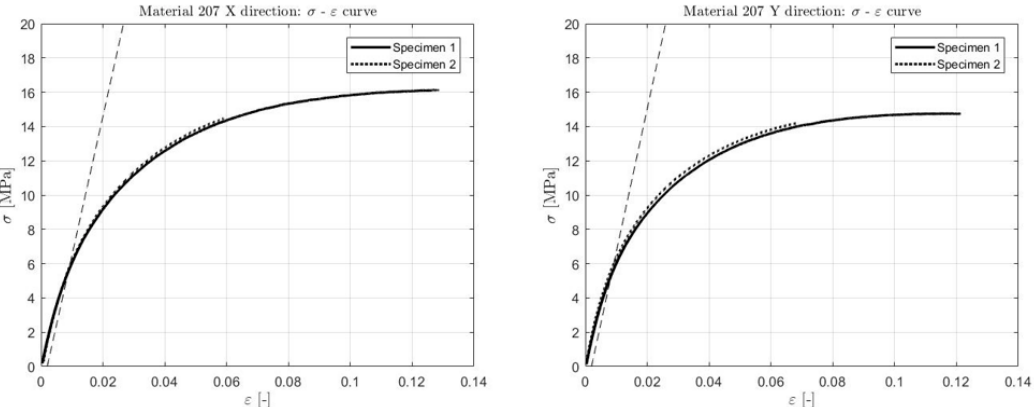
Figure 9. Material 207 tensile tests.